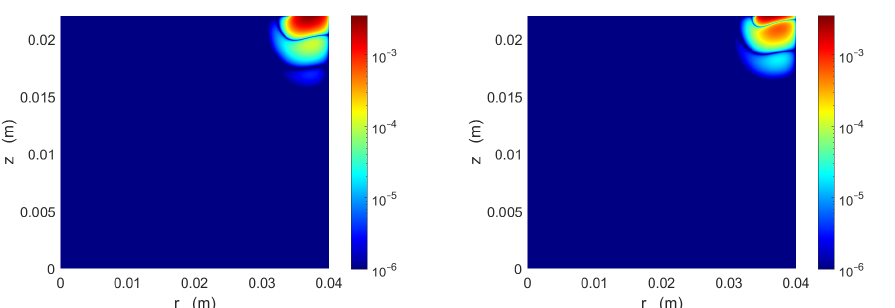
(cid:12) (cid:12) (cid:12) (left) and (cid:12) (cid:61) [ g ∗ II ( r , z )] − (cid:61) [ g ∗ I ( r , z )]